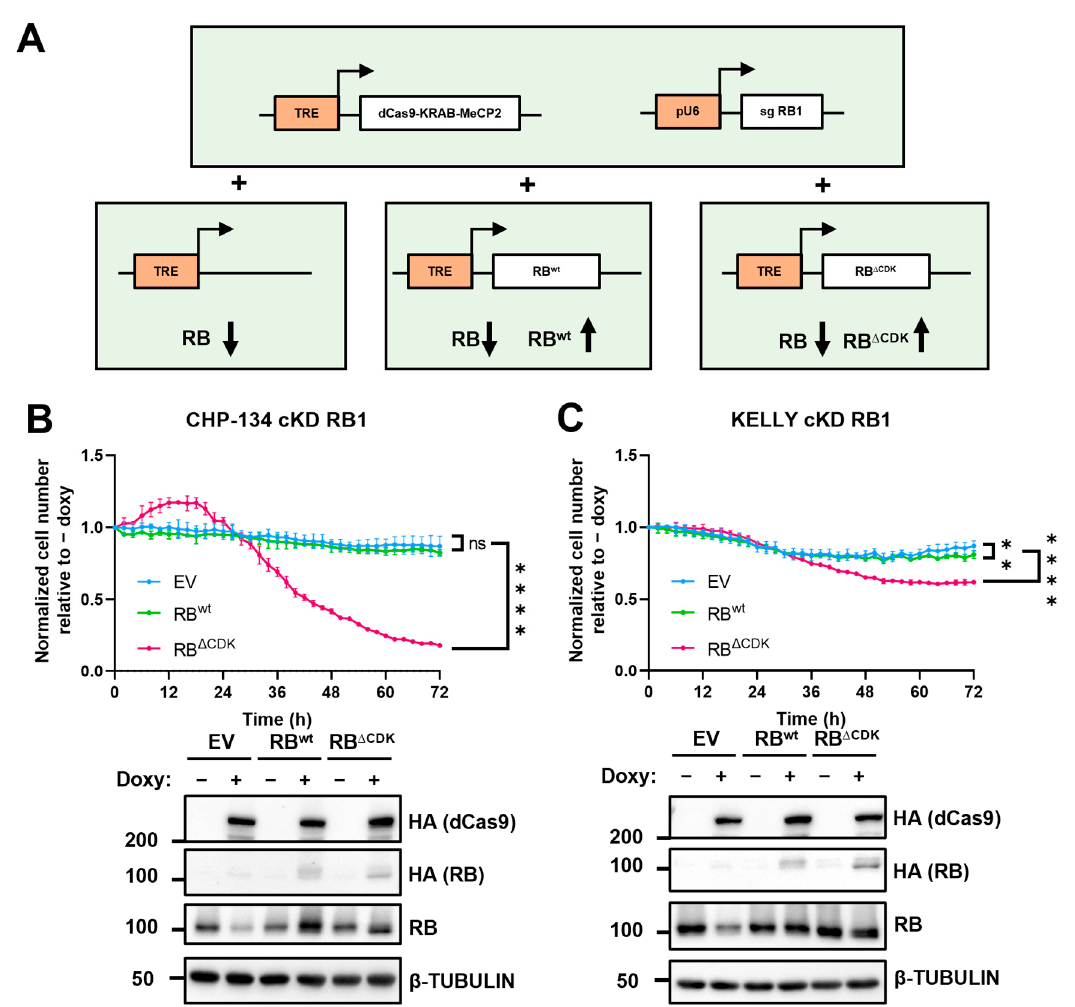
serum (FBS) for G0/G1 synchronization. Left: After 18 h, cells were harvested and stained with propidium iodide for cell cycle analysis in flow cytometry. 2n and 4n indicate the relative amount of DNA. Right: Western blot of TET21/N cells treated as described. Results are representative of two (N = 2) independent experiments ( C ) qRT-PCR on G1 synchronized TET21/N cells in the presence (-MYCN) or absence (+MYCN) of doxycycline. Data were normalized using the TBP housekeeping gene. The experiment was performed in triplicate (N = 3). Data were plotted as the mean ± SD. Statistical analyses were performed using two-way ANOVA. Error bars represent SD. *, **, indicated p < 0.05, 0.001, respectively.